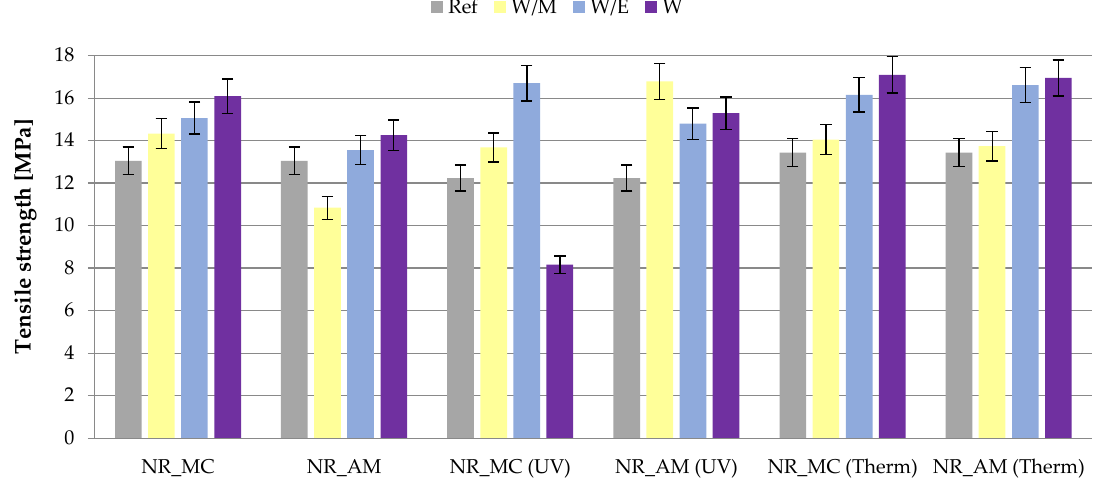
Figure 9. Results of tensile strength measurements of unaged samples, after ultraviolet (UV) and thermo-oxidative (Therm) aging.